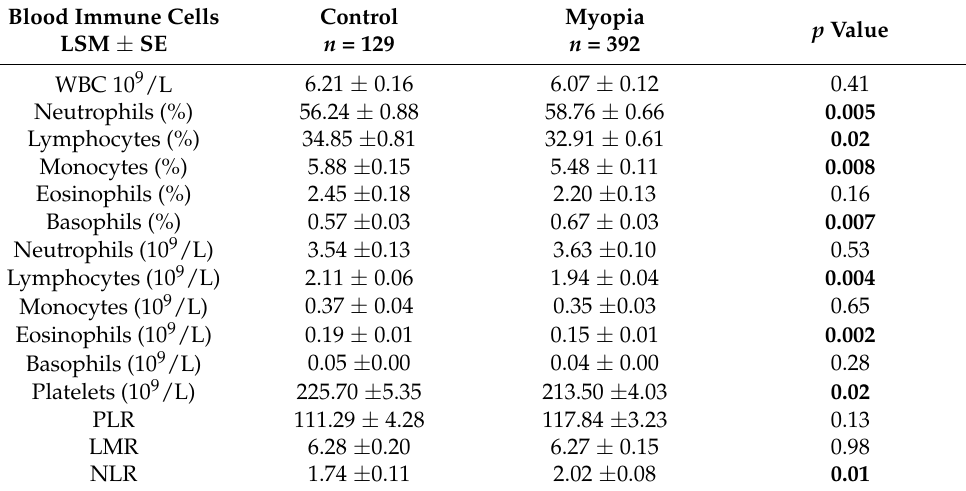
Table 2. Blood immune cells in myopic patients and